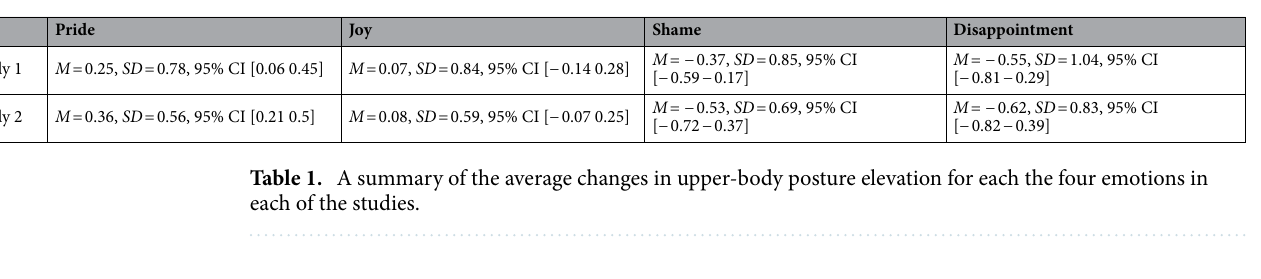
Pride Joy Shame